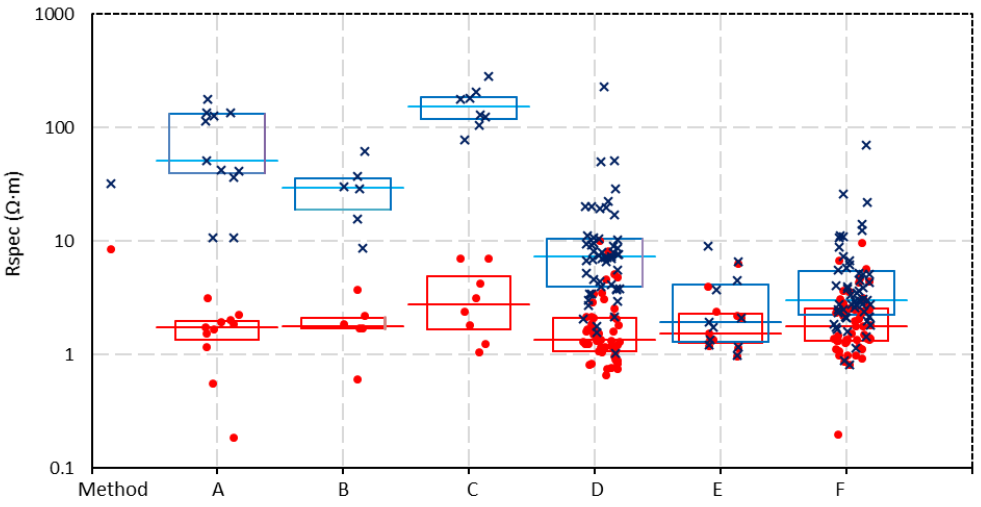
Figure 6. Values of parameters a/δ (blue crosses) and b/δ (red dots) specified for the different measuring methods (A, B... F). The parameters a and b are divided by the membrane thickness δ to express the material properties of the membrane material. To prevent overlap of the data points, X- values are slightly offset on the X-axis. Values below 0.0001 or above 10 are offset to the borders of the graph. The horizontal lines indicate the median value for each data cluster, while the boxes indicate the lower and upper quartiles.